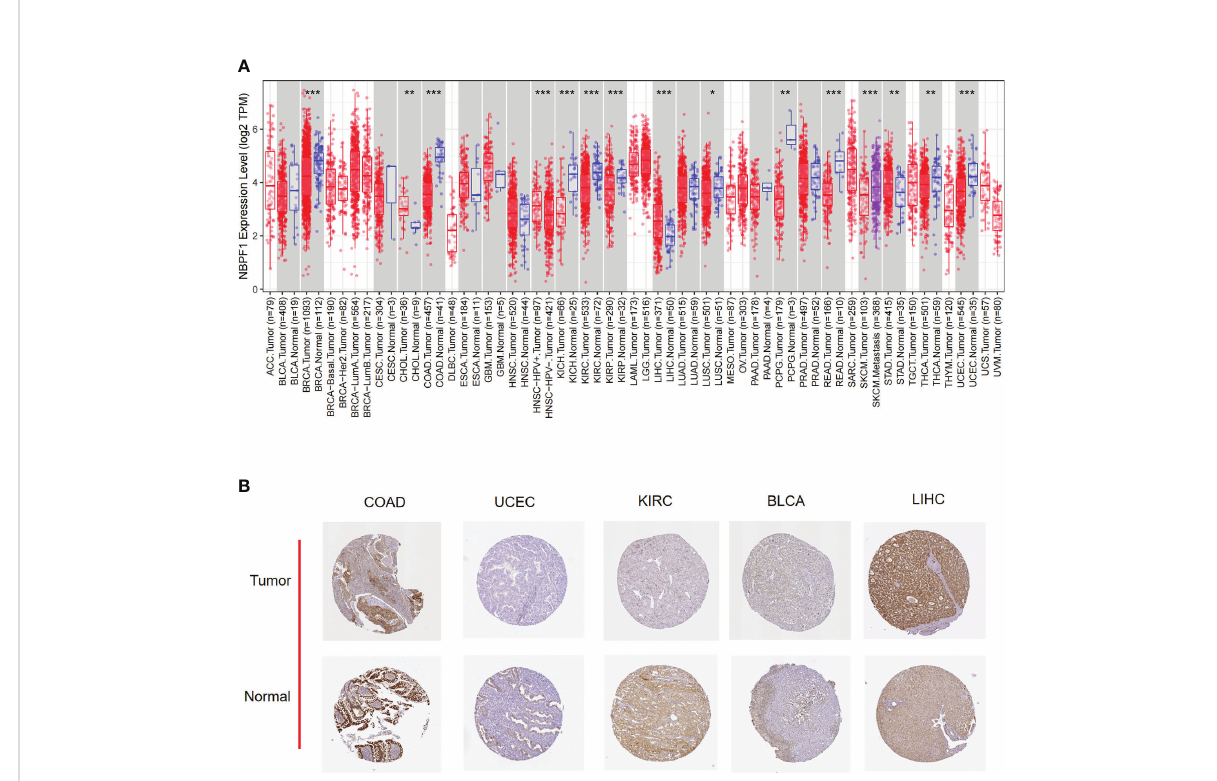
FIGURE 2 The expression of NBPF1 in human cancers. (A) The expression status of the NBPF1 gene in normal tissues and tumors taken from the TIMER2 database. (B) NBPF1 protein expression based on immunohistochemistry staining taken from the Human Protein Atlas database. (*P<0.05; **P < 0.01; ***P <